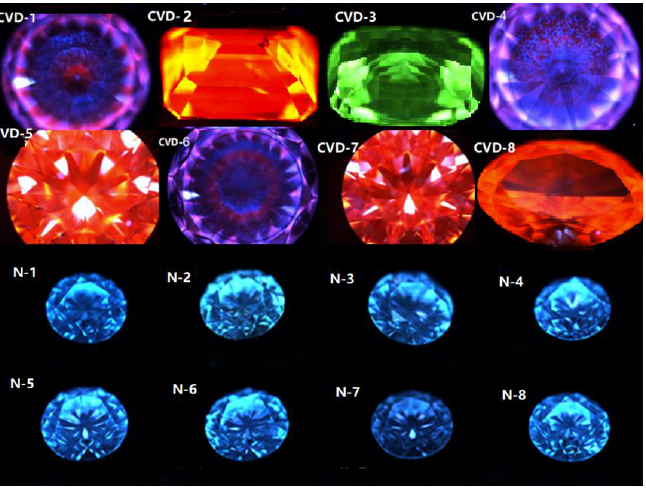
Figure 8. Fluorescence of CVD synthetics and natural diamonds under DiamondView.